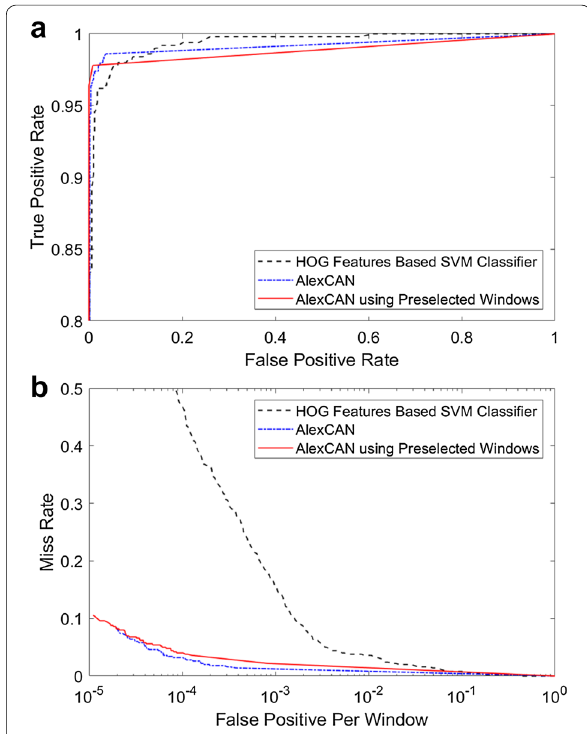
Fig. 7 a ROC’s and b DET curves for three different